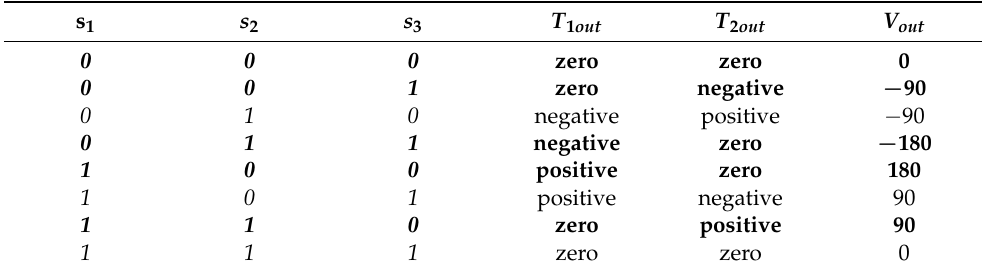
Table 1. Firing signals and output voltage.